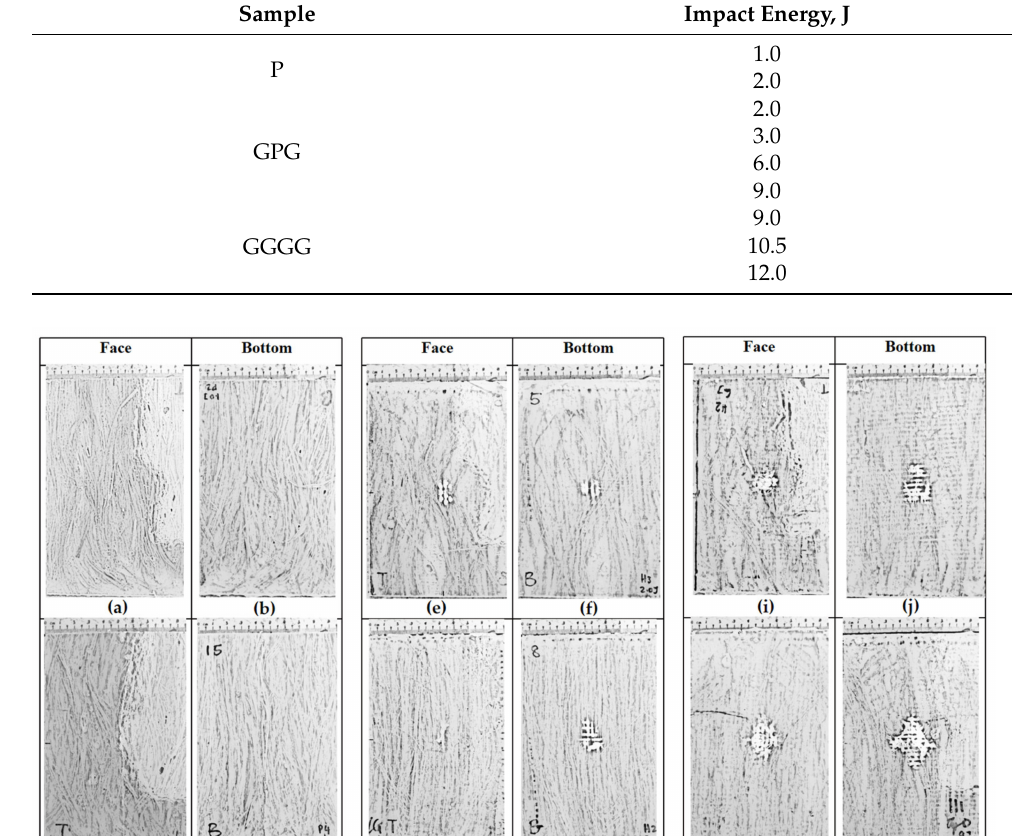
Table 2. Impact energy range for the low-velocity impact test.